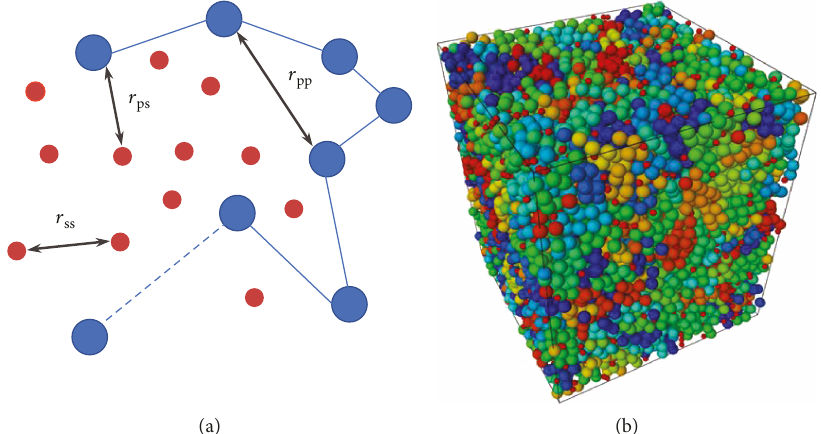
Figure 1: (a) A schematic view of the model used in the MD simulations. (b) A snapshot of the simulation box containing polymers and small molecules. Di ff erent chains are shown with di ff erent colors to improve visibility. Small molecules appear as small red spherical